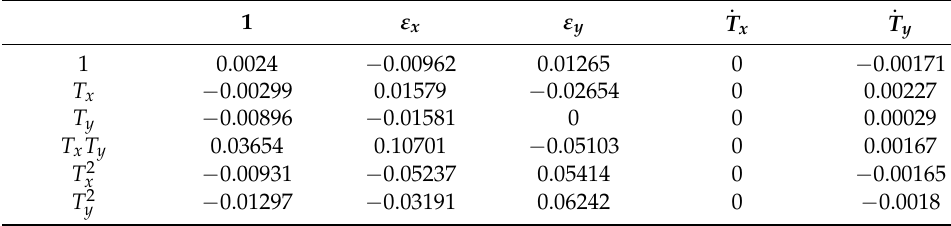
Table 8. Fitting results for (cid:101) D tx , ty .